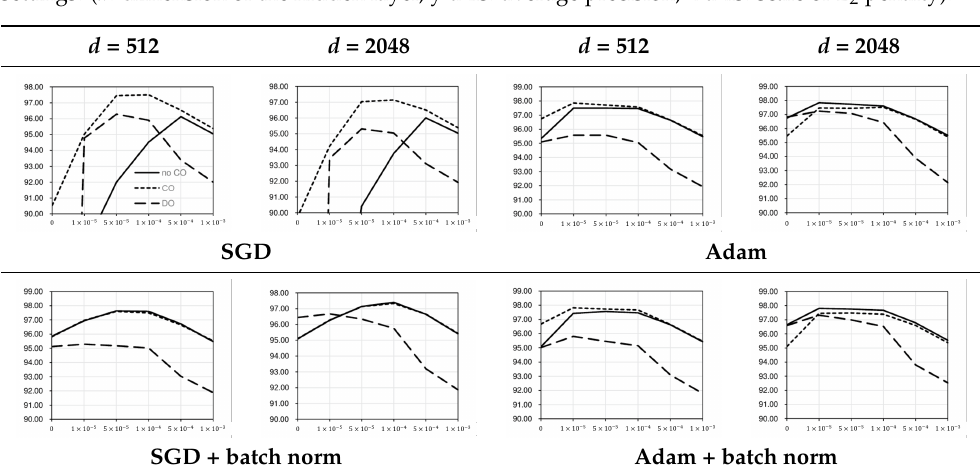
Table 5. Detailed performance change by applying Cost-Out or dropout in TDC-same with various settings. ( d : dimension of the hidden layer, y-axis: average precision, x-axis: scale of L 2